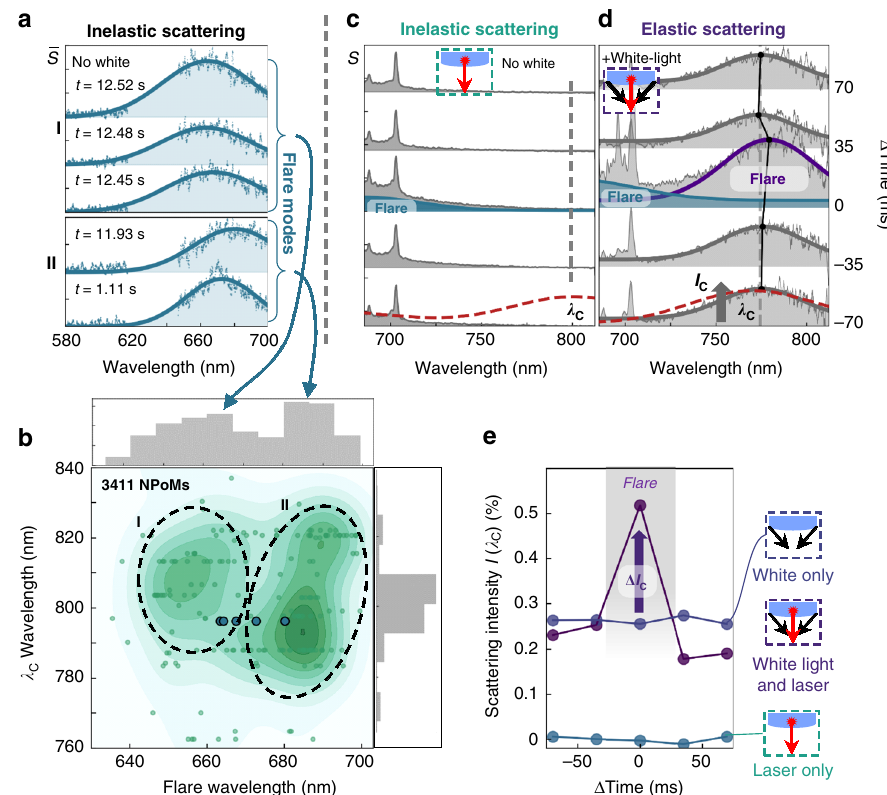
Fig. 2 Spectral characteristics of fl are events. a Different fl are inelastic scattering spectra (with persistent SERS lines subtracted, (cid:1) S ) from a single NPoM, collected at different times t . Spectra sorted into groups I,II by emission wavelength. b Mapping plasmon coupled-mode wavelength λ C against fl are mode centre wavelength λ f for fl ares from 3411 NPoMs. Two distinct groups are identi fi ed, grey histograms show distributions. Points corresponding to spectra in a are circled. c, d Time-dependent raw scattering spectra for longer-wavelength spectral window, ( c ) taken with laser only, or ( d ) with white-light and 633 nm laser irradiation simultaneously. Initial λ C mode position (black line) transiently redshifts during fl are (purple curve) at Δ t = 0, blue curves show fi t to fl are beneath SERS lines. For laser alone, no coupled mode is visible (dashed line shows λ C mode taken with white light prior to kinetic series). e Detected intensity I ( λ C ) from ( c, d ) normalised to Lambertian scatter, extracted around fl are event. Additional fl are emission ( Δ I C ) only seen with both laser and white-light illumination